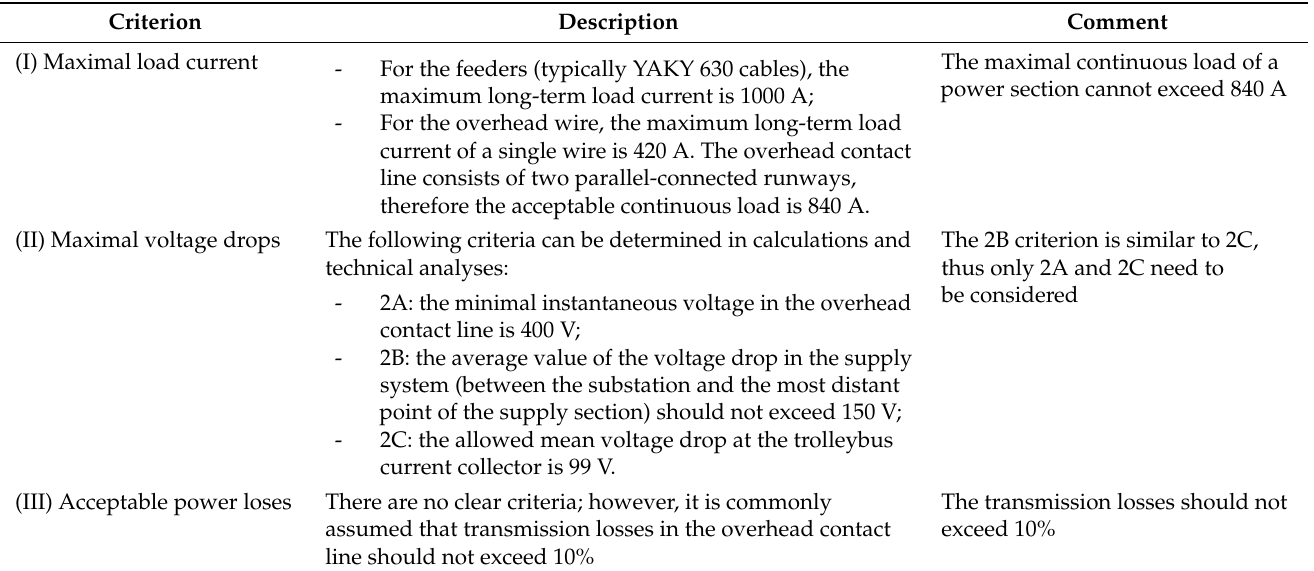
Table 2. Criteria for verification of possibility to use trolleybus overhead line to supply electric cars charging